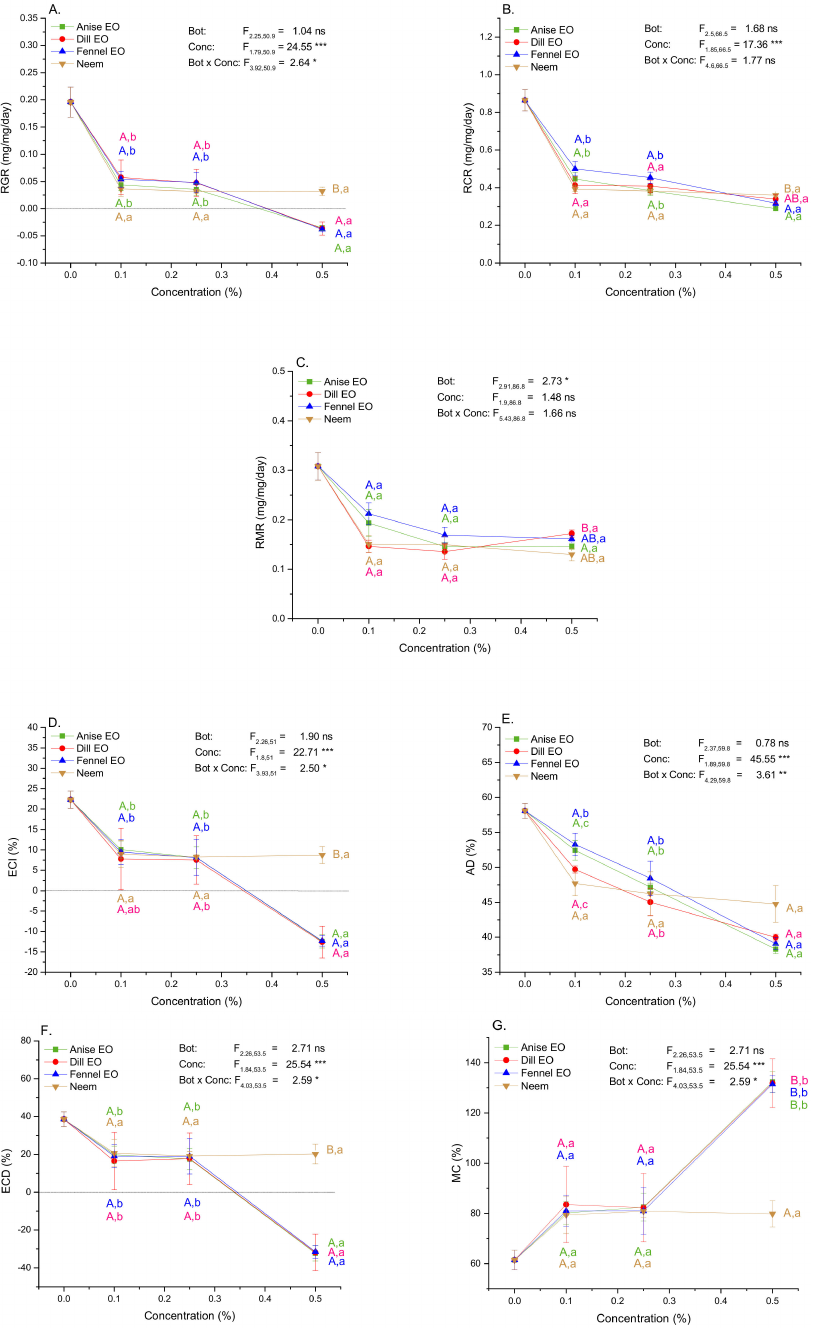
Figure 4. Nutritional indices (mean ± SE) in 4th instar gypsy moth larvae after 48 h of feed- ing on control and diet treated with EOs or neem. RGR − relative growth rate ( A ); RCR − relative consumption rate ( B ); RMR − relative metabolic rate ( C ); ECI − efficiency of conversion of ingested food ( D ); AD − approximate digestibility ( E ); ECD − efficiency of conversion of digested food ( F ); MC − metabolic cost ( G ). F − values obtained by nonparametric two-way ANOVA indicate significance of the main and interaction effects of botanical type (Bot) (anise, dill, and fennel EOs and commercial neem-based insecticide) and concentration (Conc) ( * p < 0.05, ** p < 0.01, *** p < 0.001). Significant differences among specific experimental groups are presented by different large colored letters A, B (EO and neem comparisons within each concentration) and small letters a, b (comparisons among concentrations within each EO and neem) (LSM contrasts, p <